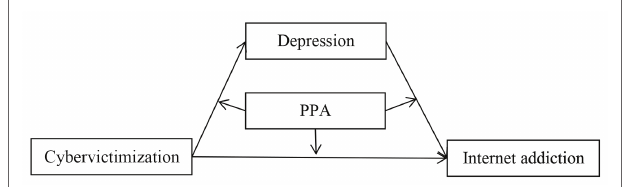
FIGURE 1 | The proposed mediated moderation model. PPA, prosocial peer